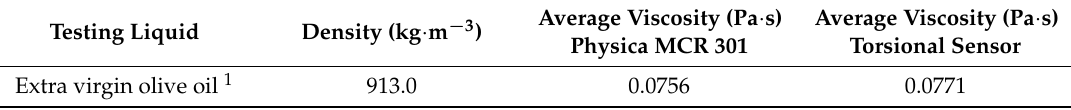
Figure 11. Measured attenuation in 1mm diameter carbon steel rod embedded in an olive oil versus frequency, superimposed on the predicted attenuation curve. Table 1. Average viscosity of the test liquid (torsional sensor vs. conventional rheometer).